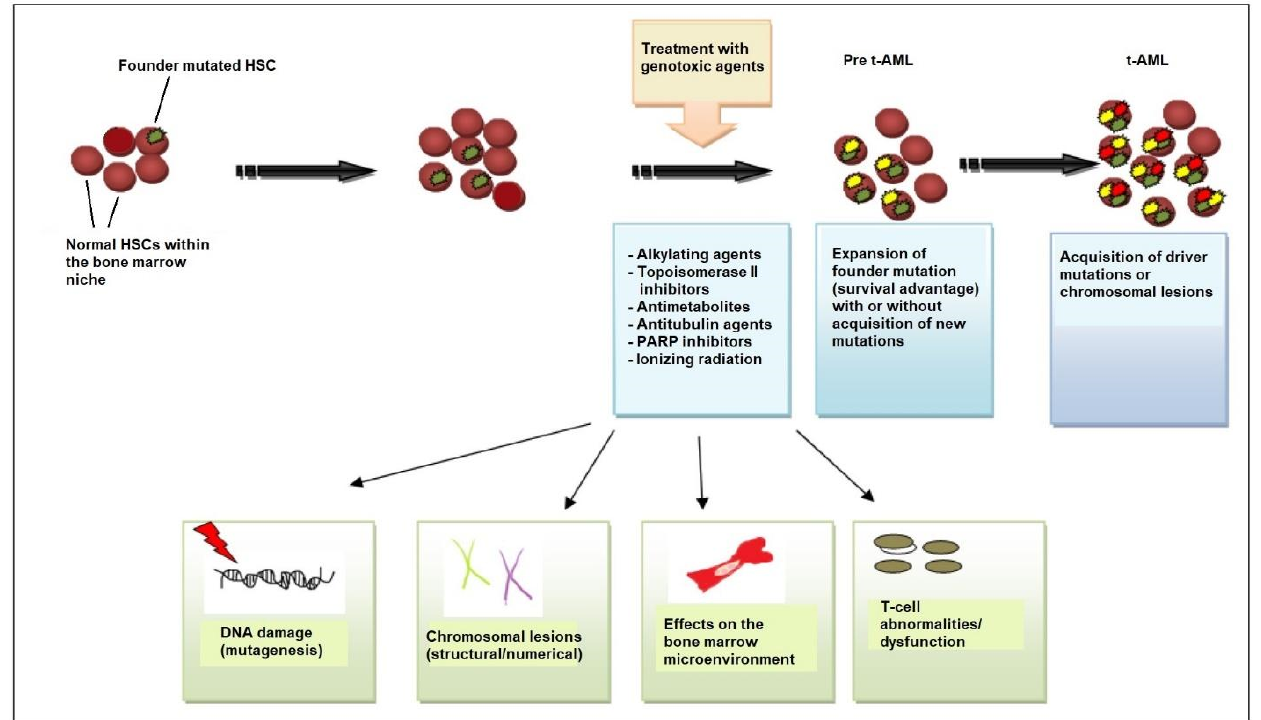
Figure 1. Pathogenesis of t-AML. Evidence supports the view that chemotherapy and/or radiation selects for the expansion of a mutant clone (founder clone) in the hematopoietic-stem-cell (HSC) and/or progenitor-cell compartment of the bone marrow that is more resistant to DNA damage. After chemotherapy/radiotherapy exposure, the pool of normal HSCs is affected and depleted, allowing the mutant clone to expand, owing to its survival advantage. Cytotoxic therapy affects the stem cell, causing DNA damage (i.e., additional mutations and/or chromosomal abnormalities) that drives the emergence of fully leukemic clones and changes in the bone marrow microenvironment, including bone marrow stromal cells and T-cell subsets (cytotoxic T-cells, regulatory T-cells). Stromal cells support HSC function but, if challenged with genotoxic agents, can inhibit normal HSC survival, providing an opportunity for the selection of pre-leukemic clones, and T-cell dysfunction interferes with tumor immunosurveillance. All these mechanisms contribute to the development of leukemic cells and ultimately to the emergence of t-AML. Abbreviations: t-AML, therapy-related acute myeloid leukemia; PARP, poly (ADP-ribose) polymerase.